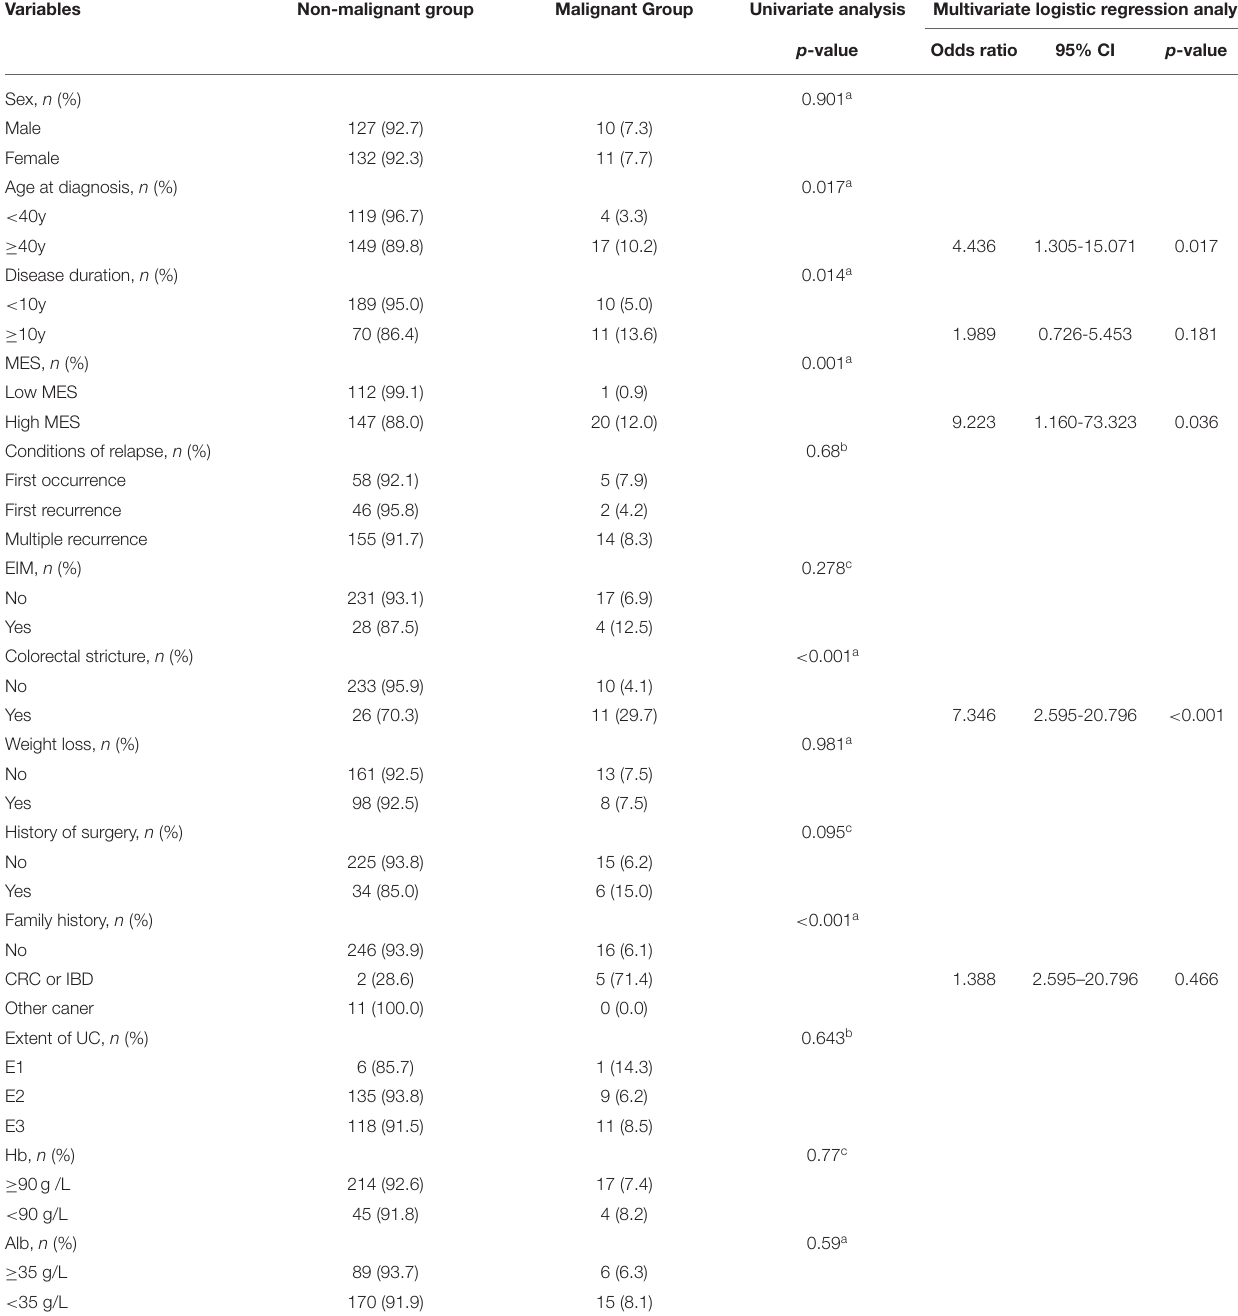
TABLE 3 | Univariable analysis and multivariate logistic regression analysis of risk factors for malignant transformation in UC. Variables Non-malignant group Malignant Group Univariate analysis Multivariate logistic regression analysis p -value Odds